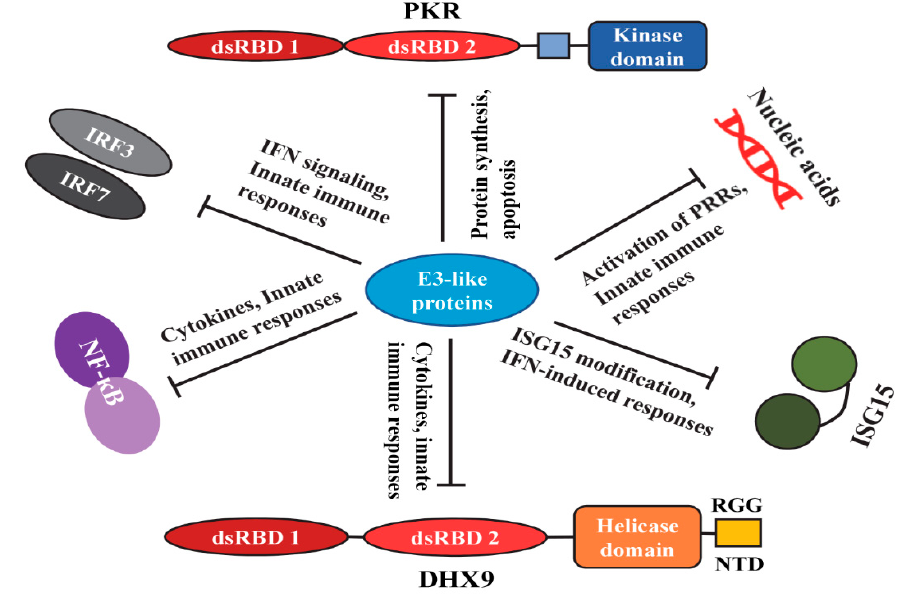
Figure 2. Schematic representation of the known signaling pathways and proteins targeted by poxvirus E3-like proteins. Poxvirus encoded E3-like proteins directly interact with multiple host proteins and modulate diverse signaling